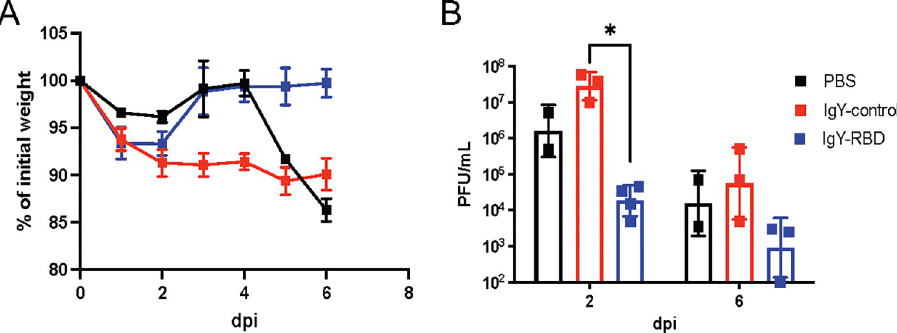
Fig 5. IgY-RBD confers protection in Ad5-hACE2 transduced mice infected with SARS-CoV-2. Mice were transduced with Ad5-hACE2 and treated with IgY-RBD or IgY-control or PBS 2 hours prior to challenge with 2019-nCoV/USA-WA1/2020 SARS-CoV-2. (A) Weights were measured daily. IgY-control (red squares; n = 6), IgY-RBD (blue squares; n = 7) antibodies or PBS (black squares; n = 4) (B) Virus titers in the lungs were measured at the indicated times post infection. Each symbol represents data obtained from one individual mouse. Data in (A) are mean ± s.e.m. Data in (B) are geometric mean ± geometric SD. P values determined by two-tailed Student’s t test. Data are from one experiment.